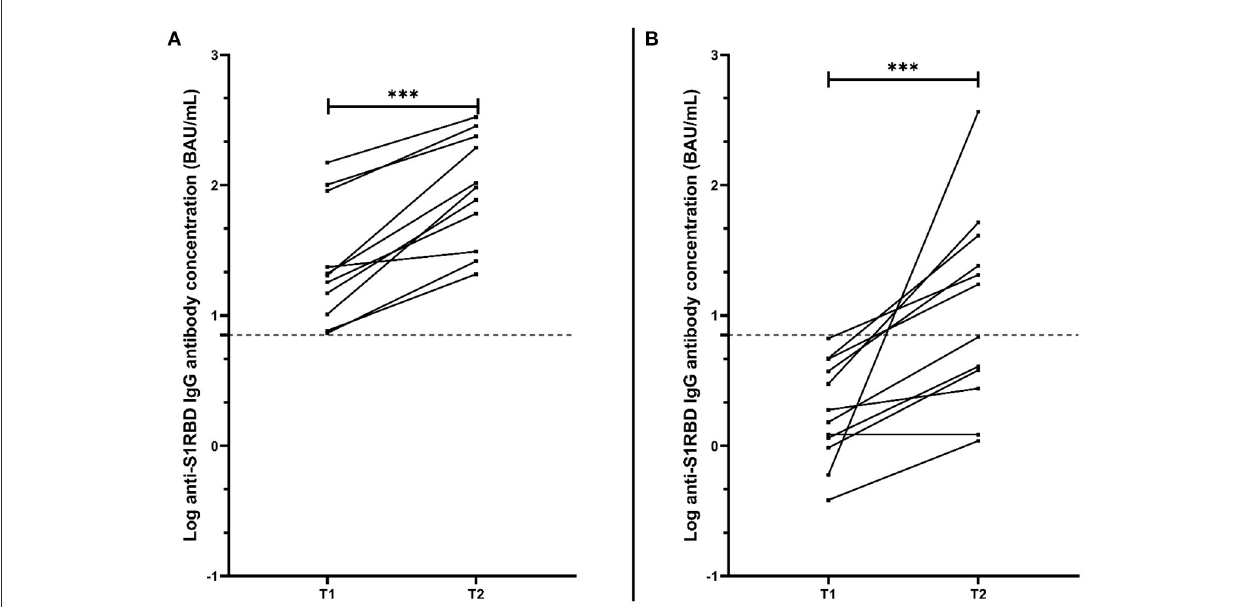
FIGURE3 Anti-S1RBD IgG antibody level comparison between matched MS volunteers receiving fingolimod at 2 different time points: T1, 3 months after the second vaccination dose; and T2, at least 2 weeks after the booster dose. (A) Represents only MS Fingolimod volunteers who were found positive for anti-S1RBD IgG at T1 ( n = 11), while (B) represents those who were found negative for anti-S1RBD IgG at T1 ( n = 12). The dotted line represents the cut-off value (7.1 BAU/mL). *** p <